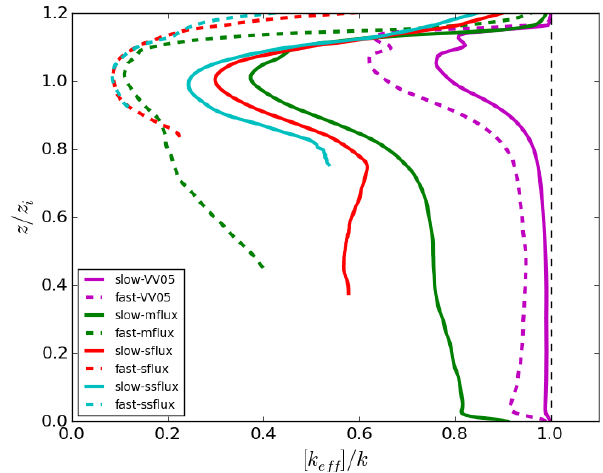
Figure 4. Vertical profiles of the horizontally averaged normalised effective chemical reaction rate [ k eff ] /k with homogeneous emis- sions for varied cases time averaged for the last 30min of the sim- ulations. Note that the vertical profiles are not plotted at altitudes where the concentration of tracer B is equal to zero.